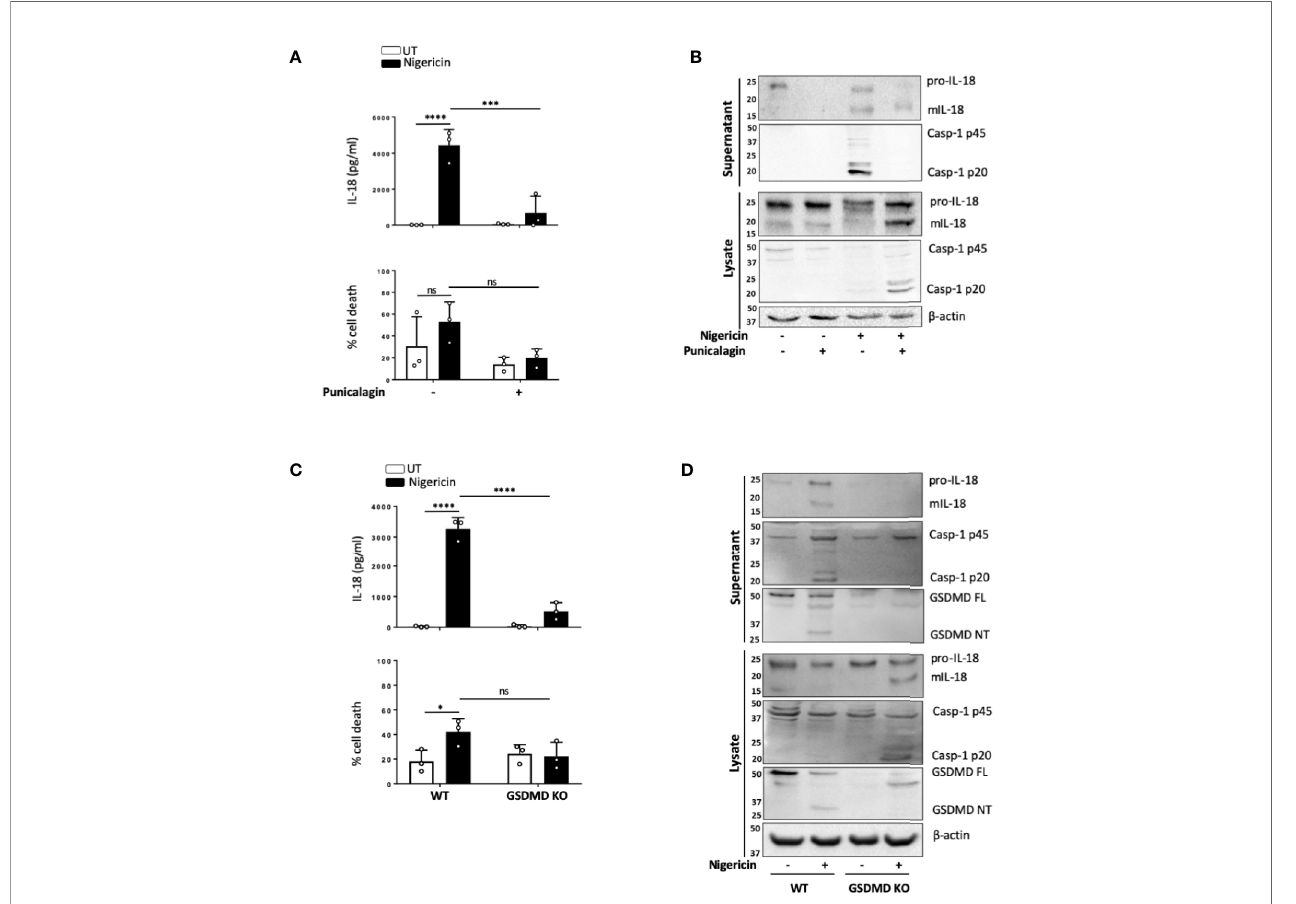
FIGURE 5 | mIL-18 release from unprimed monocytes is dependent on GSDMD. (A, B) Unprimed THP-1 cells pre-incubated with punicalagin (50 µM, 15 min) prior to treatment with nigericin (10 µM, 45 min). (C, D) Unprimed WT and GSDMD KO THP-1s were treated with nigericin (10 µM, 45 min). (A, C) Secreted IL-18 was measured by ELISA and cell death was measured by LDH assay and shown as percentage relative to total cell death, n=3 independent biological replicates, mean ± S.D., *P < 0.05; ***P <0.001; ****P <0.0001; ns (not signi fi cant) using one-way ANOVA comparing each sample to nigericin only treated sample (A) or two-way ANOVA comparing UT to nigericin treated WT THP-1s as well as nigericin treated WT THP-1s to nigericin treated GSDMD KO THP-1s. (C) . (B, D) Western blot analysis of THP-1 cells for mIL-18 (18 kDa), pro-IL-18 (24 kDa), mCaspase-1 (20 kDa), pro-Caspase-1 (45 kDa), GSDMD full length (FL, 53 kDa), GSDMD N- terminus (NT, 31 kDa), as well as loading control b -actin (42 kDa). Blots are representative of at least 3 independent